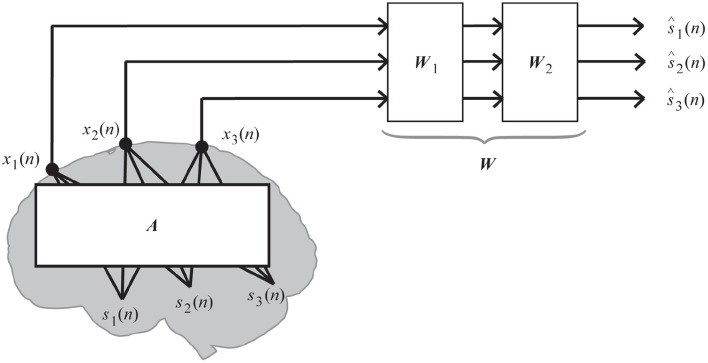
Linear mixing and demixing of EEGs (Kanoga and Mitsukura, 2017).